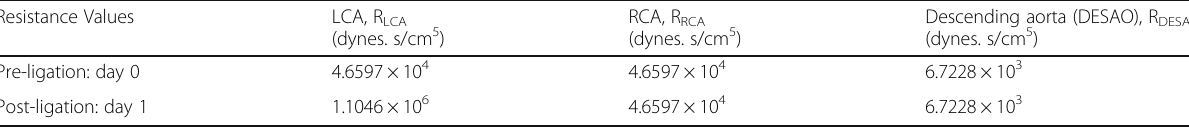
RCA, R RCA (dynes. s/cm 5 )